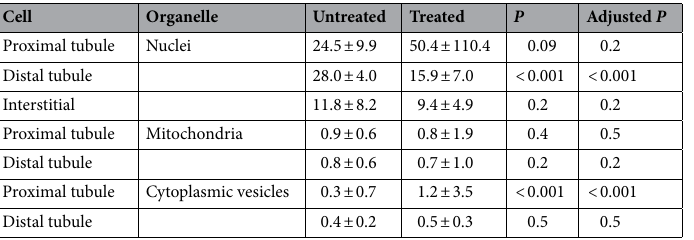
Table 1. Electron microscopic morphometry of renal cortical intracellular organelles * * Areas are in units of µm 3 . The Benjamini–Hochberg procedure derived false discovery rate-adjusted P